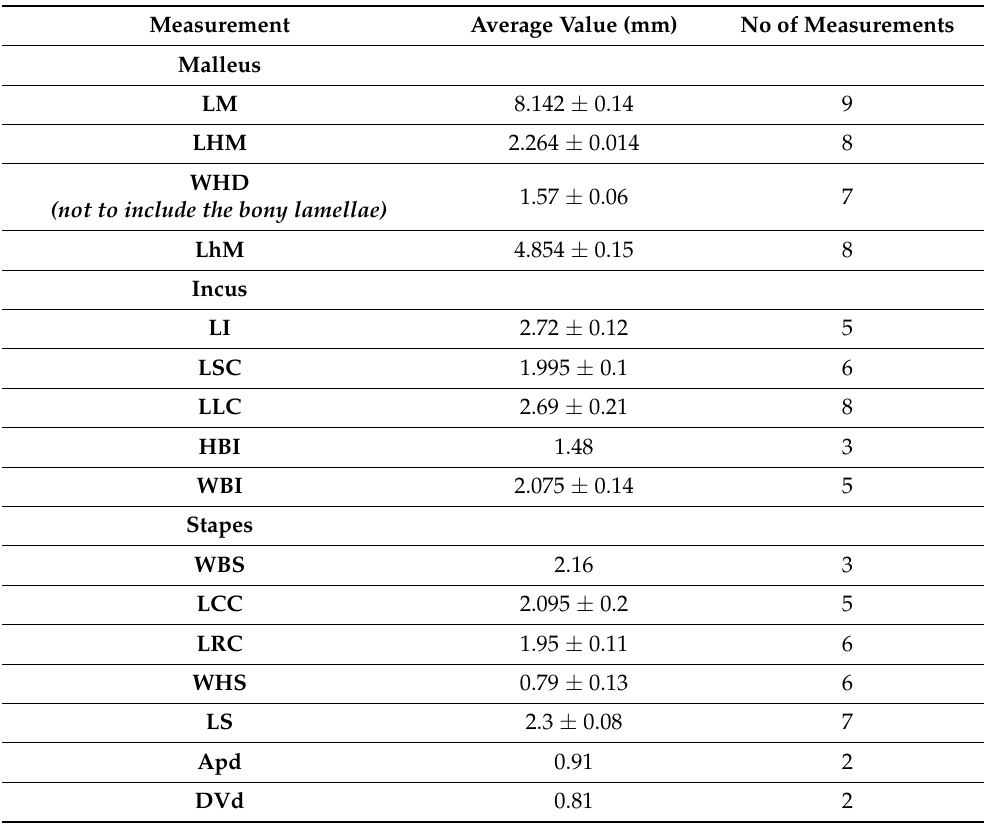
Table 1. Metrical data for the auditory ossicles in the badger ( Meles meles ). Measurement Average Value (mm) No of Measurements Malleus LM 8.142 ±